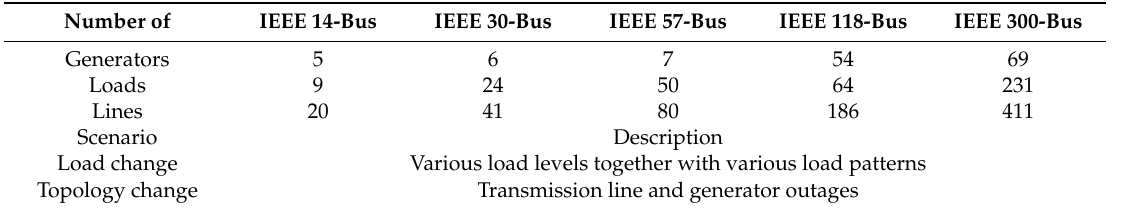
Table 1. System data and the simulation